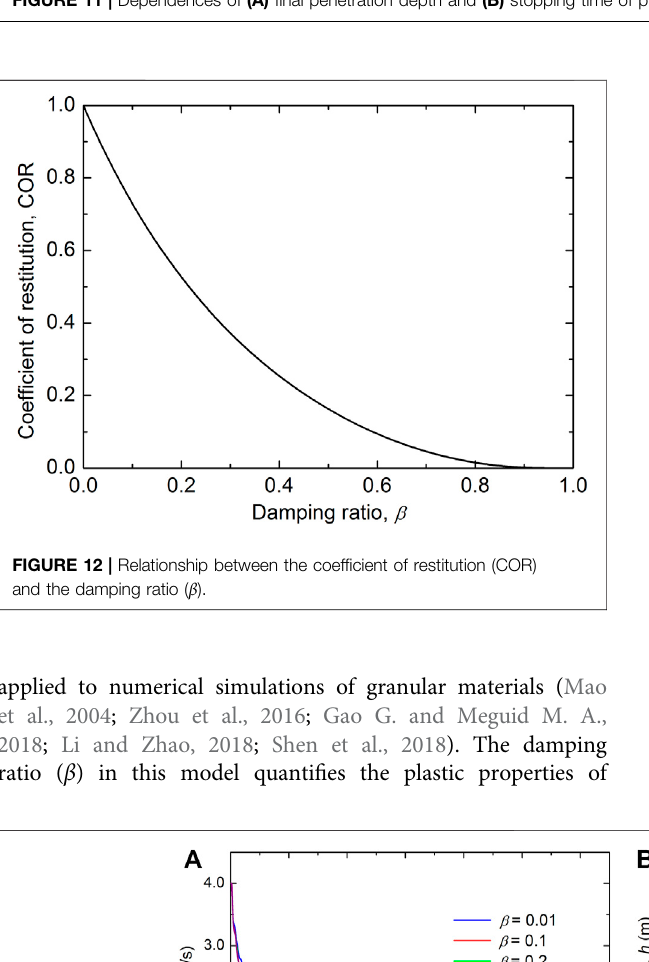
Frontiers in Earth Science |